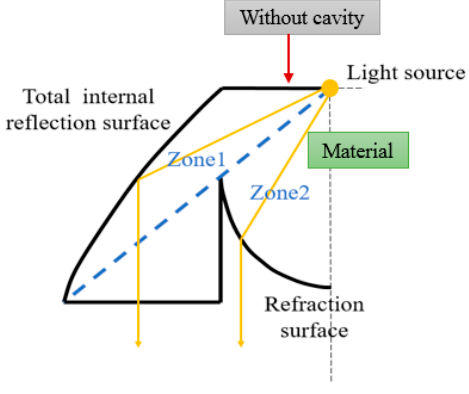
Figure 9. The concept of the new TIR collimator.